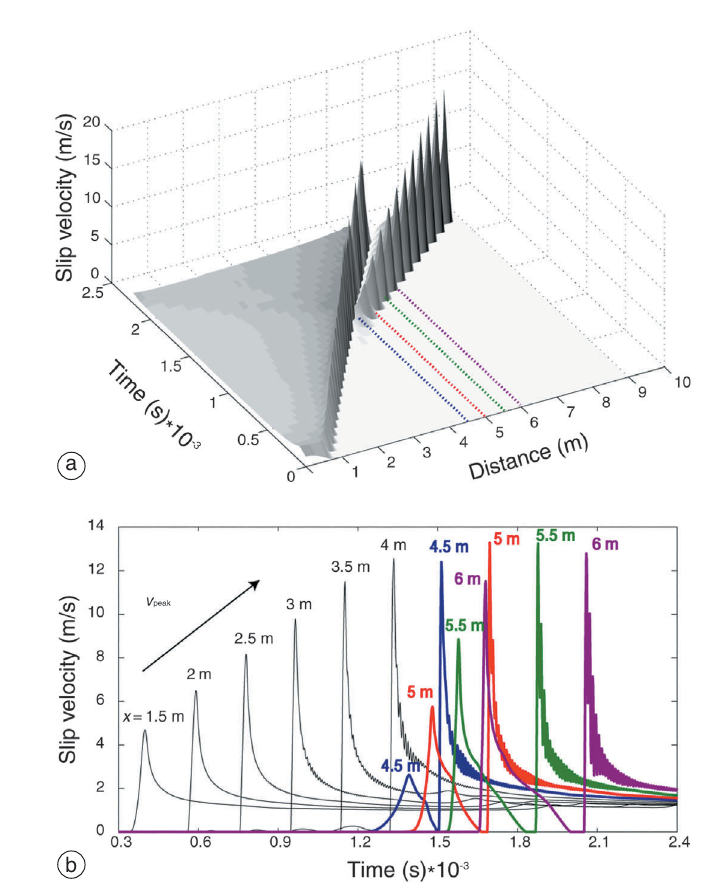
Fig. 4a,b. Dynamic rupture propagation on a strong velocity weakening fault. The model and constitutive pa- rameters used for these calculations are listed in table II. Panel a) shows the spatio-temporal evolution of slip ve- locity. We have drawn this plot with a reduced resolution in order to emphasize the increase in peak slip veloc- ity. Panel b) shows the time histories of slip velocity in different positions along the fault: black lines identify points located before the point where crack accelerates to a super-shear rupture velocity, while coloured curves identify those points located in the region where the crack has